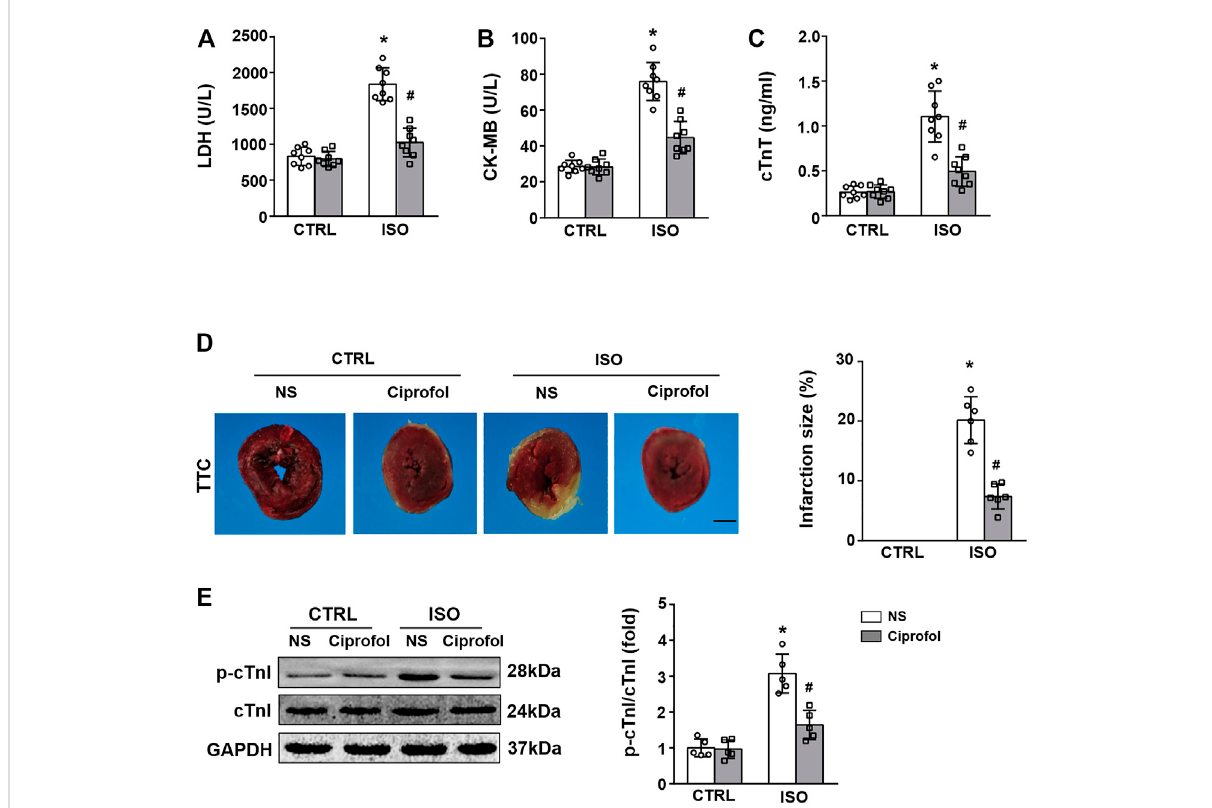
FIGURE 1 CiprofoltreatmentsuppressedISO-inducedmyocardialdamage.CK-MB (A) ,LDH (B) andcTnT (C) activitiesineachgroupweredetected( n =8) (D) TTC staining in each group was detected. ( n = 6). (E) Western blotting analysis of p-cTnI, and cTnI in the heart ( n = 5). p p < 0.05 compared to the CTRL group. # p < 0.05 compared to the ISO